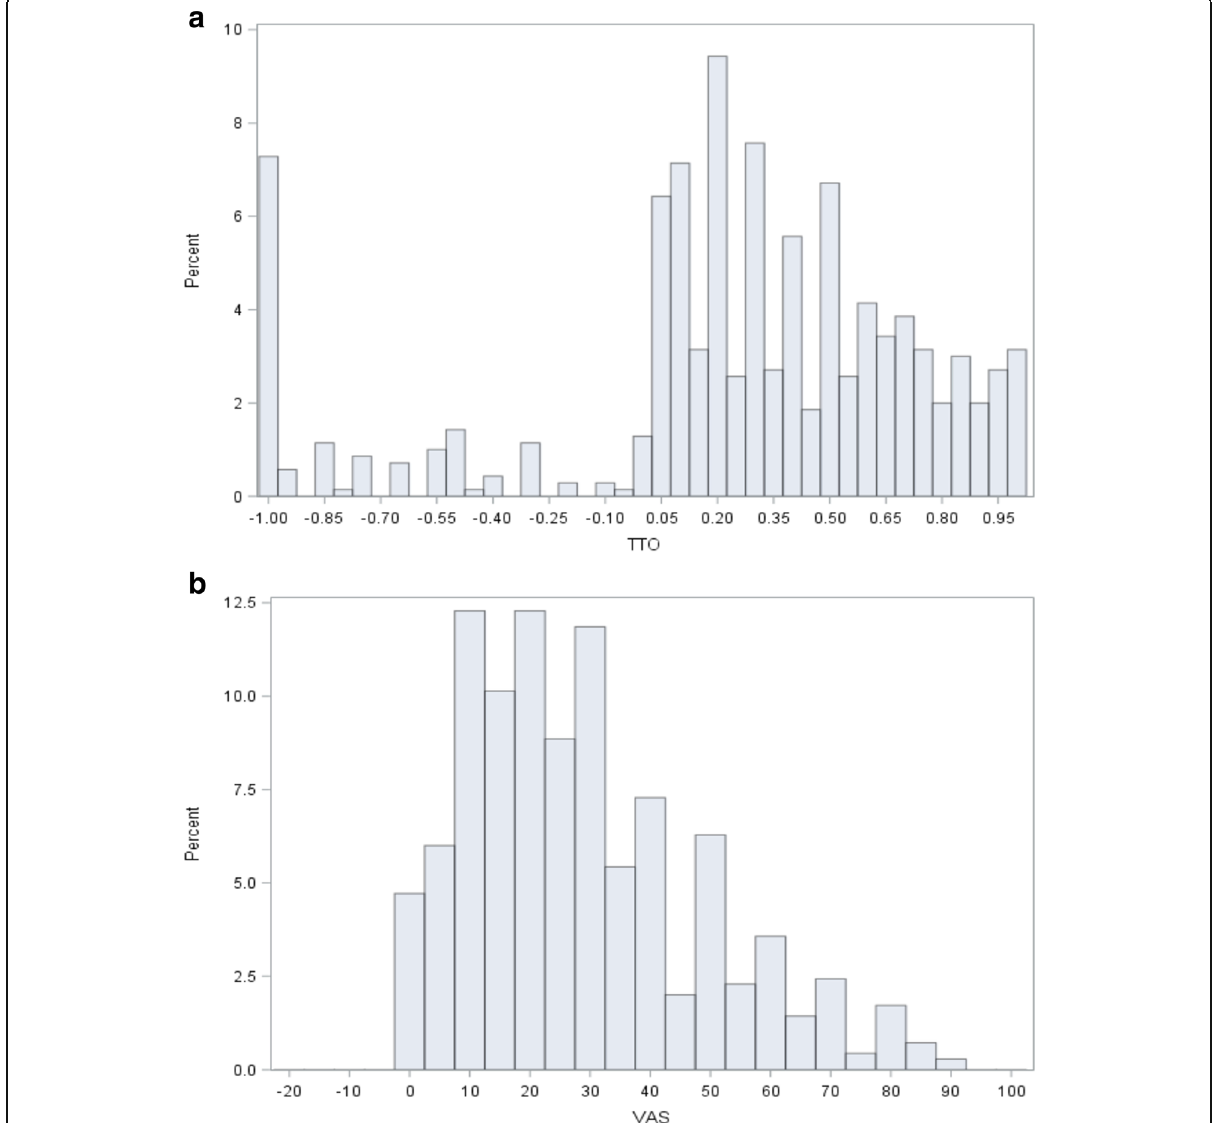
Fig. 1 Distribution of the TTO utility weights ( a ), the VAS ( b ). a . TTO utility weights. b . VAS